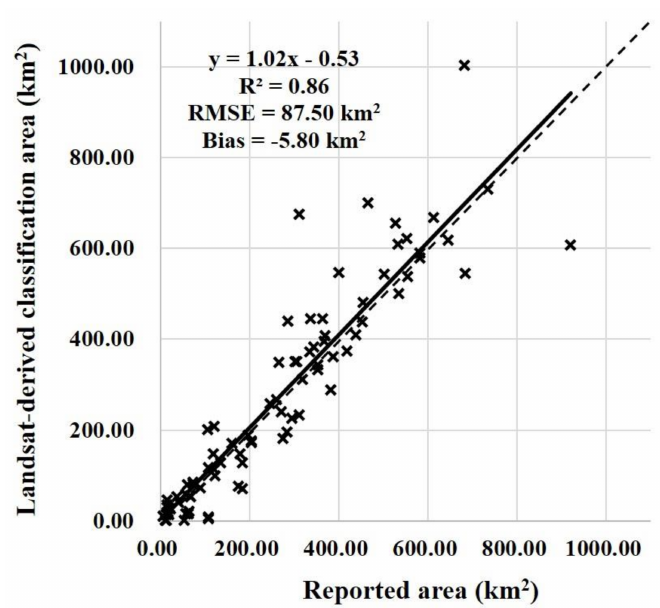
Figure 15. Comparison of the reported area from the agricultural statistics department of Jiangsu and the identified area from the OCSVC-based rice classification map of 2016 at the county-level. The dashed line represents the 1:1